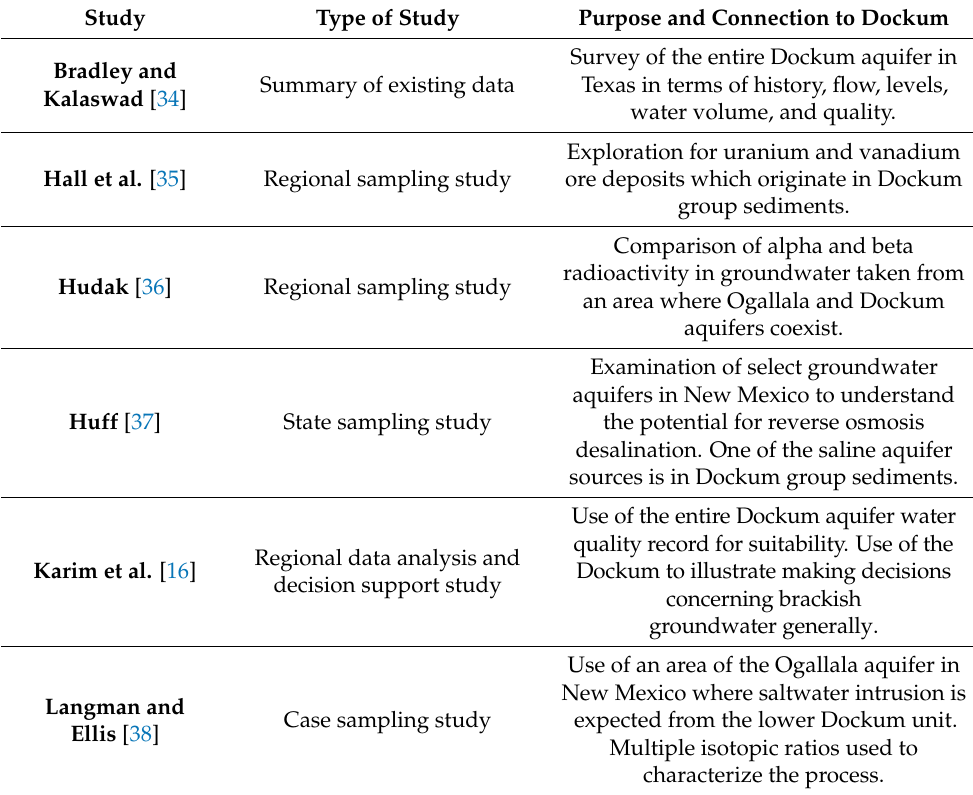
Table 1. Selected Dockum aquifer-related groundwater